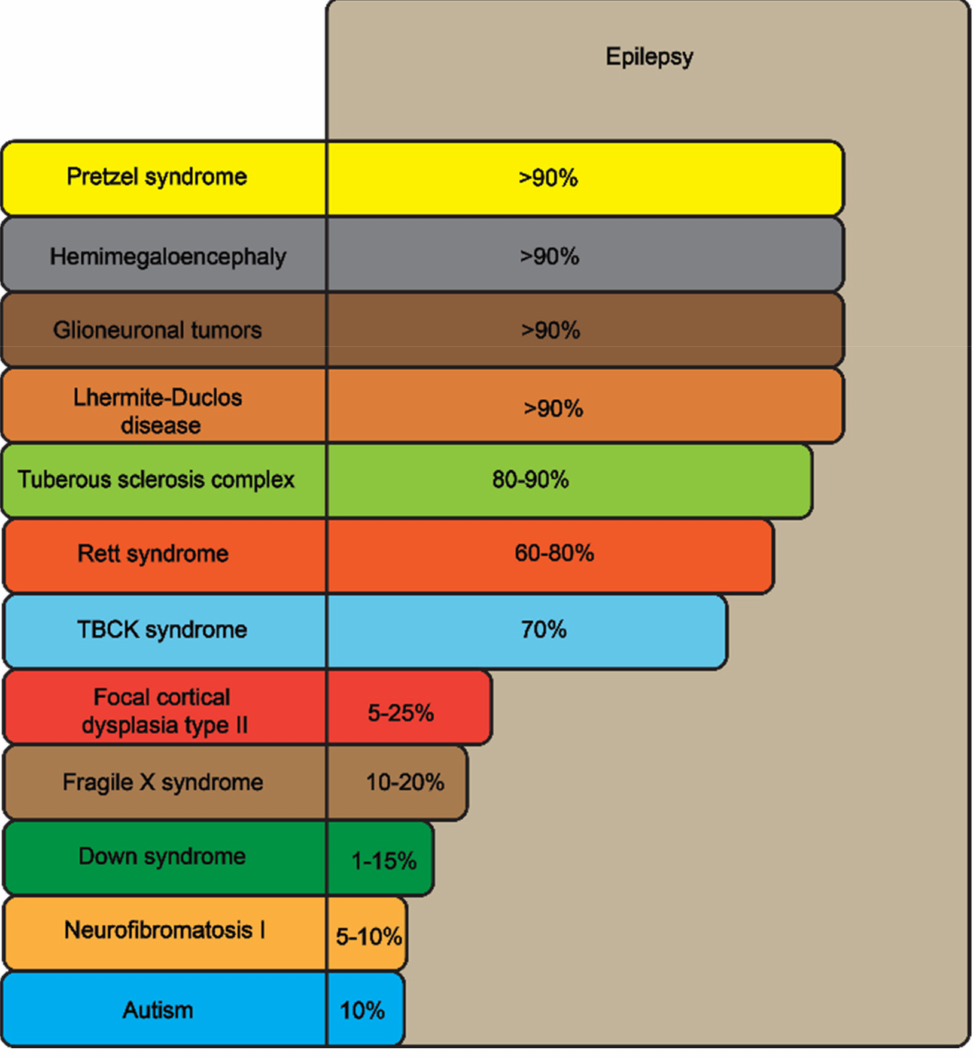
Figure 2. Epilepsy as a key shared clinical feature of multiple disorders associated with deficient mTOR signaling (also see Table 1 for details), based on relative occurrence (estimated as % of affected patients with